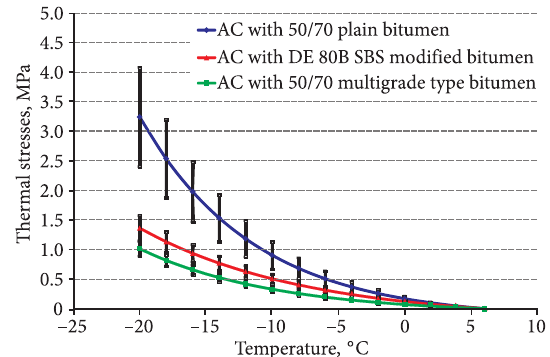
Fig. 5. Calculated thermal stresses induced in restrained asphalt concrete specimens by cooling with a rate of V T = 10 ºC/h